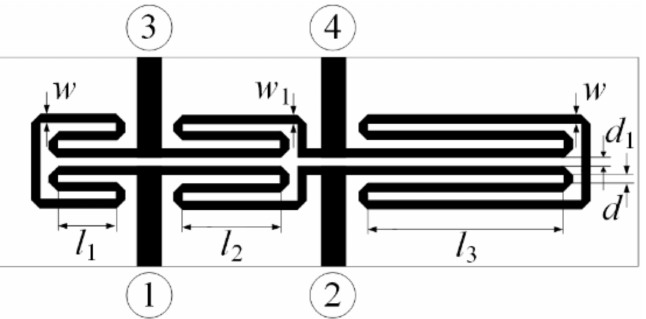
Figure 10. Layout of the miniaturized folded rat-race coupler [68]; the numbered circles (1 through 4) mark the structure